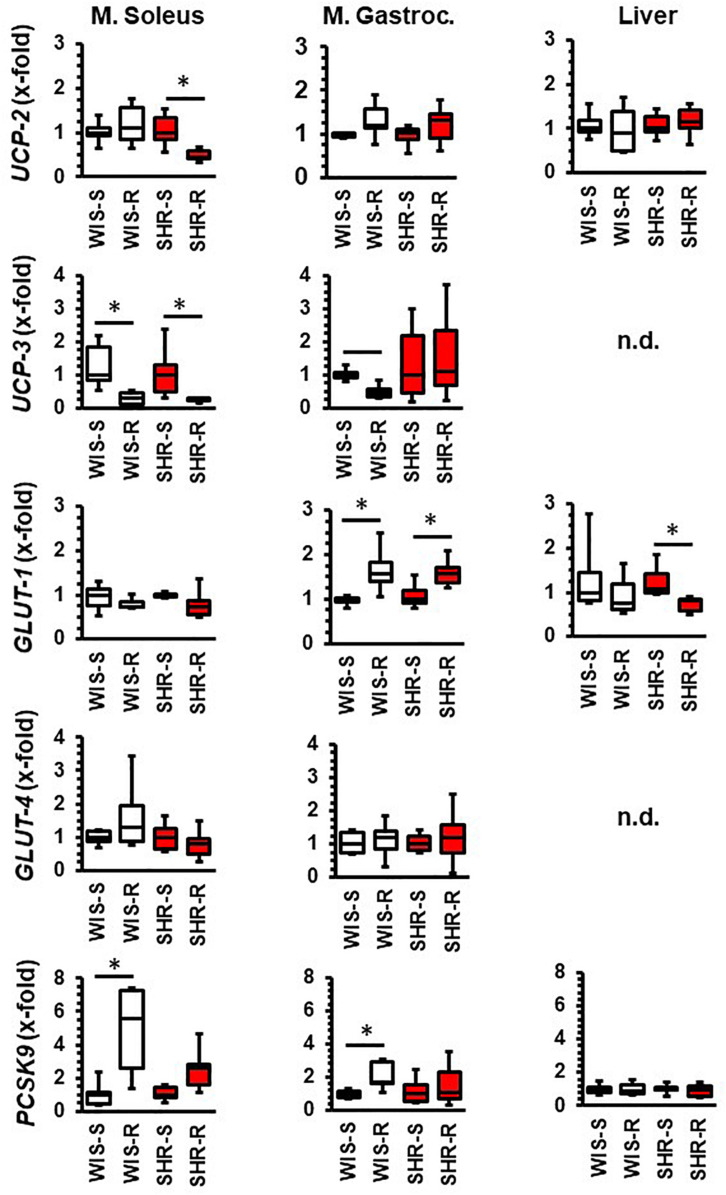
Effect of free running wheel activity (R) on mRNA expression in muscle tissue and liver and comparison between both strains. Sedentary controls (S) for each strain set as 1. Data are box plots representing the 25, 50, and 75% quartile and the whiskers representing the total range. Data represent the mRNA expression at the age of 11.5 months of exercise. n.d., not detectable. ∗p < 0.05 vs. sedentary (sed).